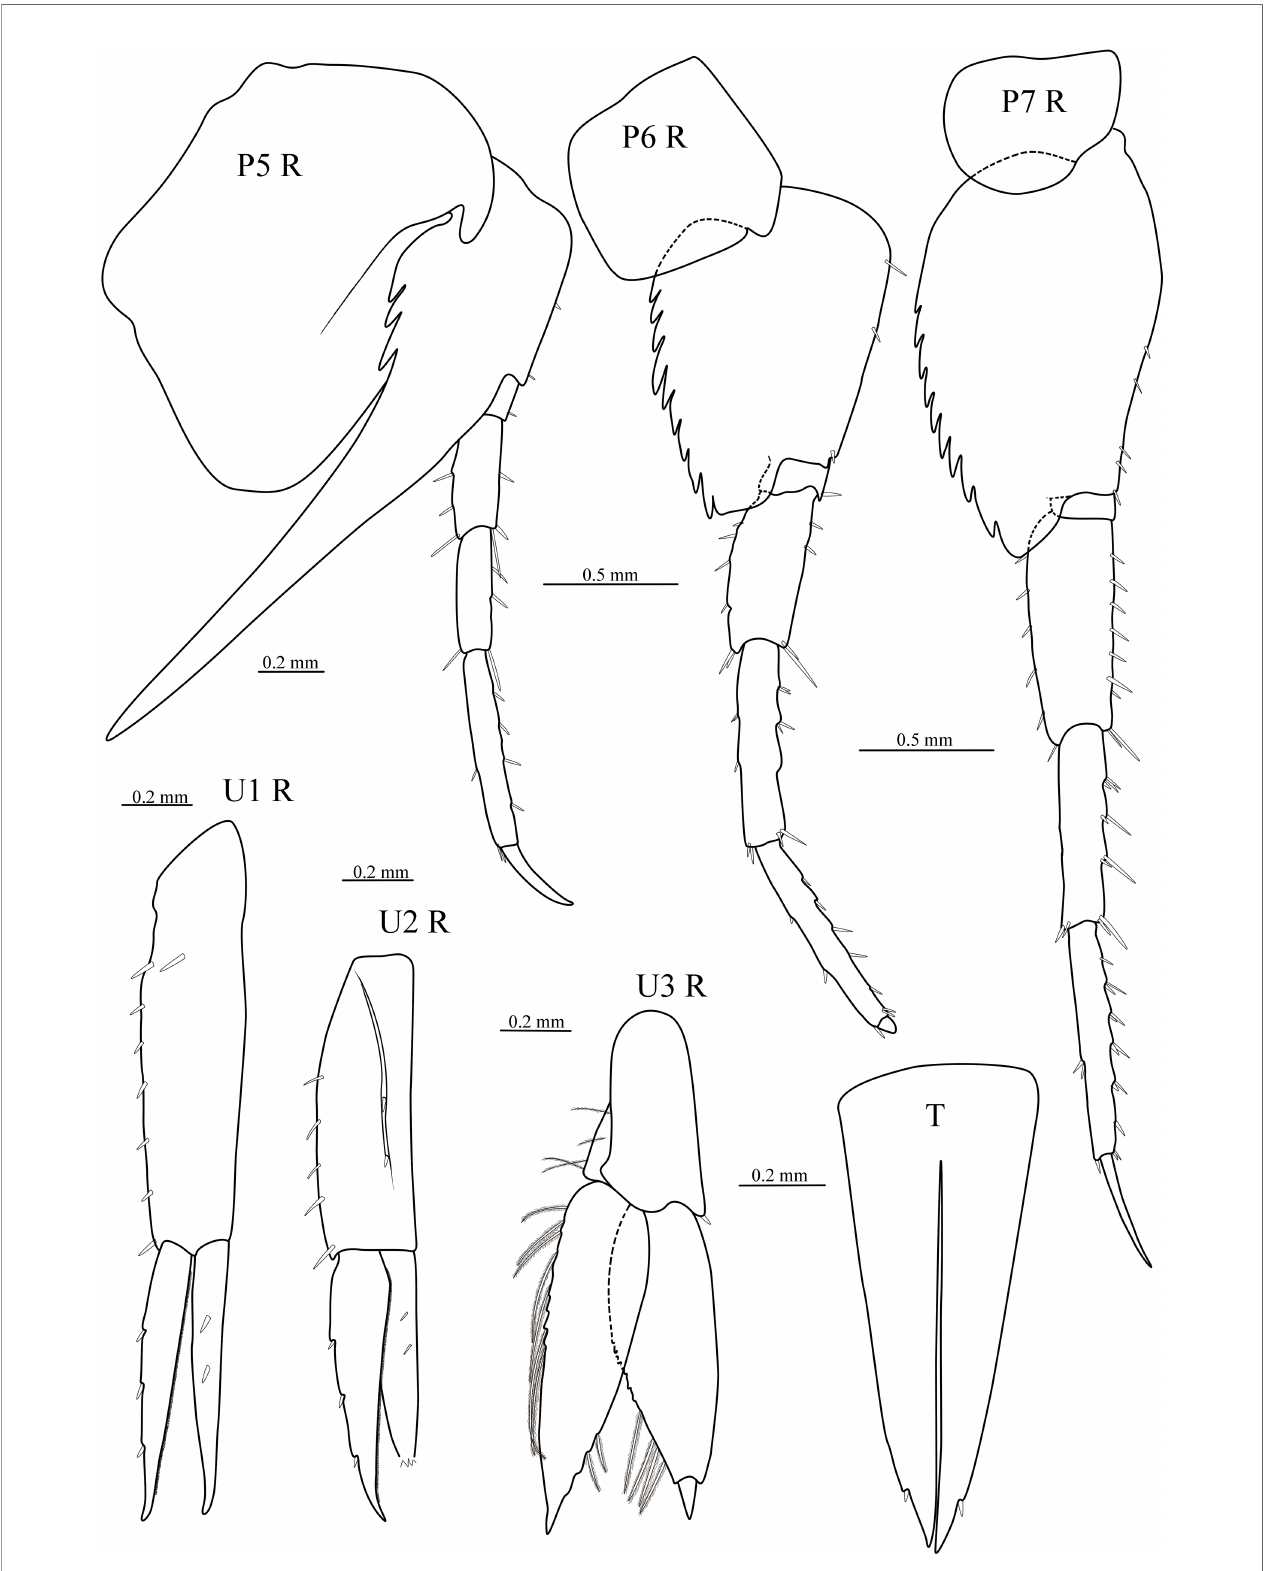
FIGURE 3 | Cyphocaris lubrica sp. nov., MBM 286819, male holotype (9.1 mm), showing pereopod 5 – 7, uropod 1 – 3 and telson. For abbreviations, see